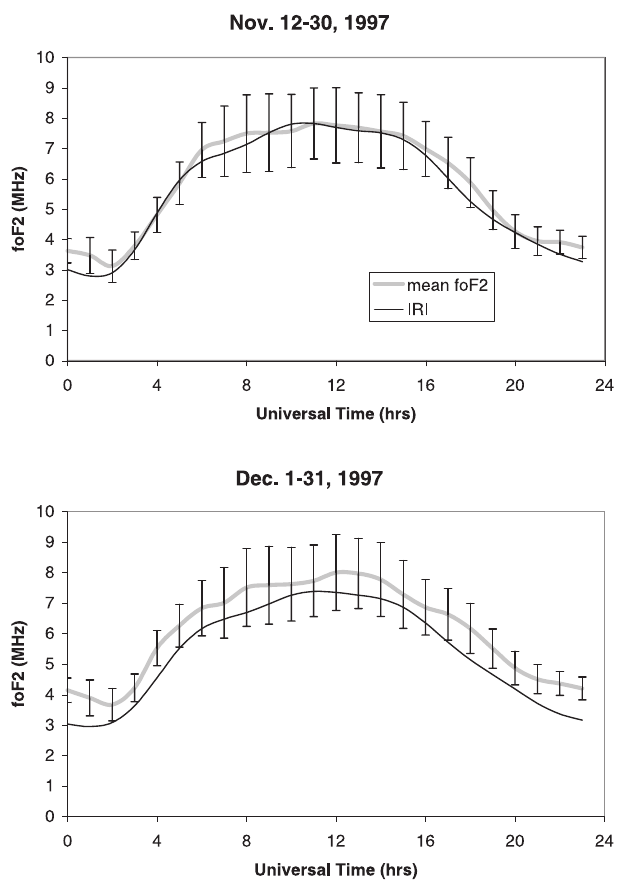
Fig. 5. Mean and standard deviation of the diurnal variation of foF2 at Grahamstown, South Africa, for November and December, 1997, together with the prediction from the International